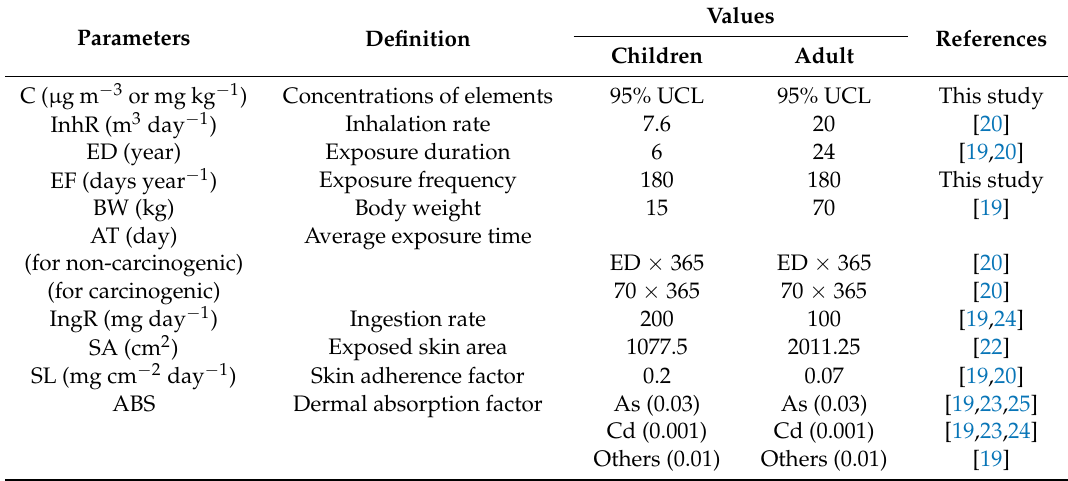
Table 1. Exposure factors for health risk assessment model.